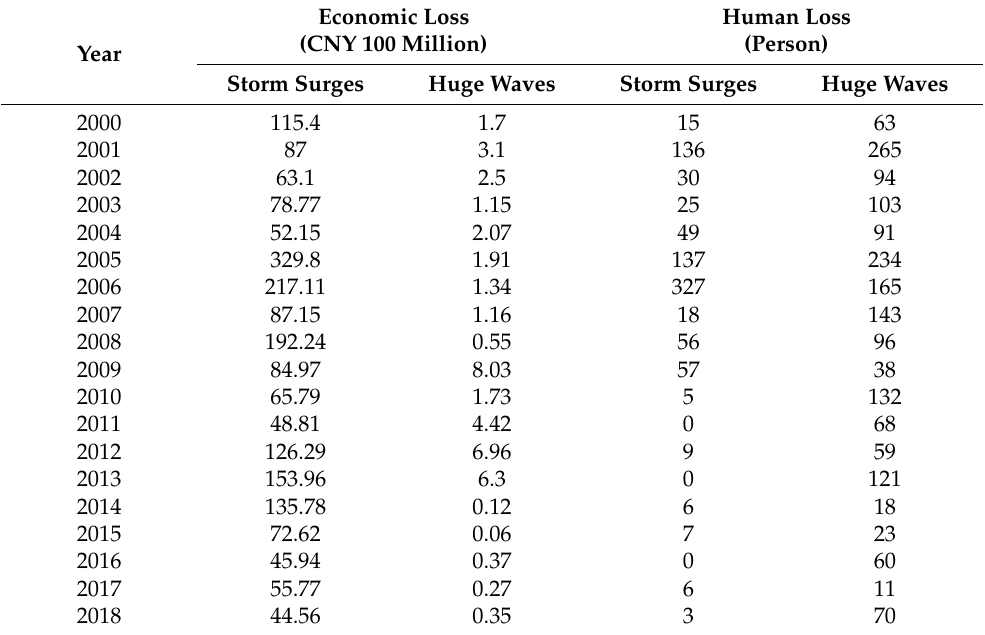
Table 1. Statistics of losses caused by storm surges and huge waves in China.